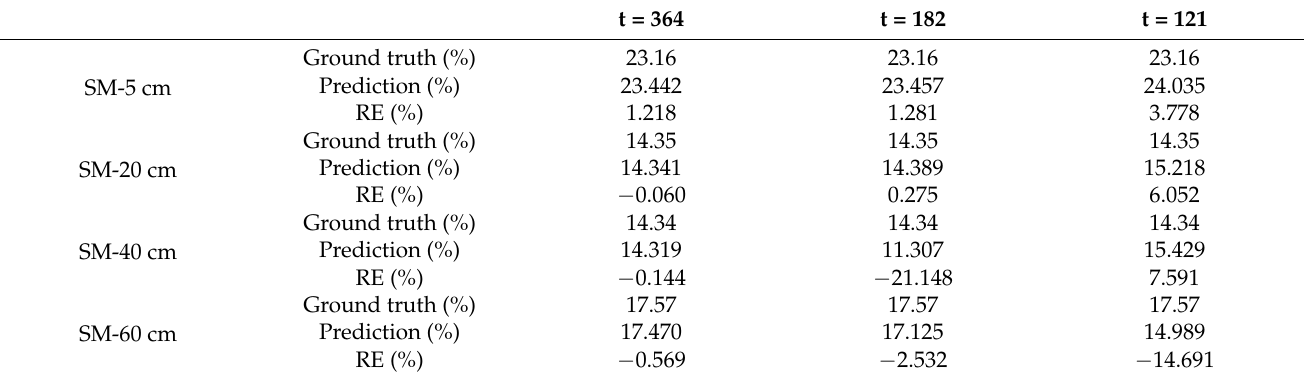
Figure 5. Comparison of prediction errors with different sequence lengths. Table 9. Prediction results of DataA at different depths with different input sequence lengths.